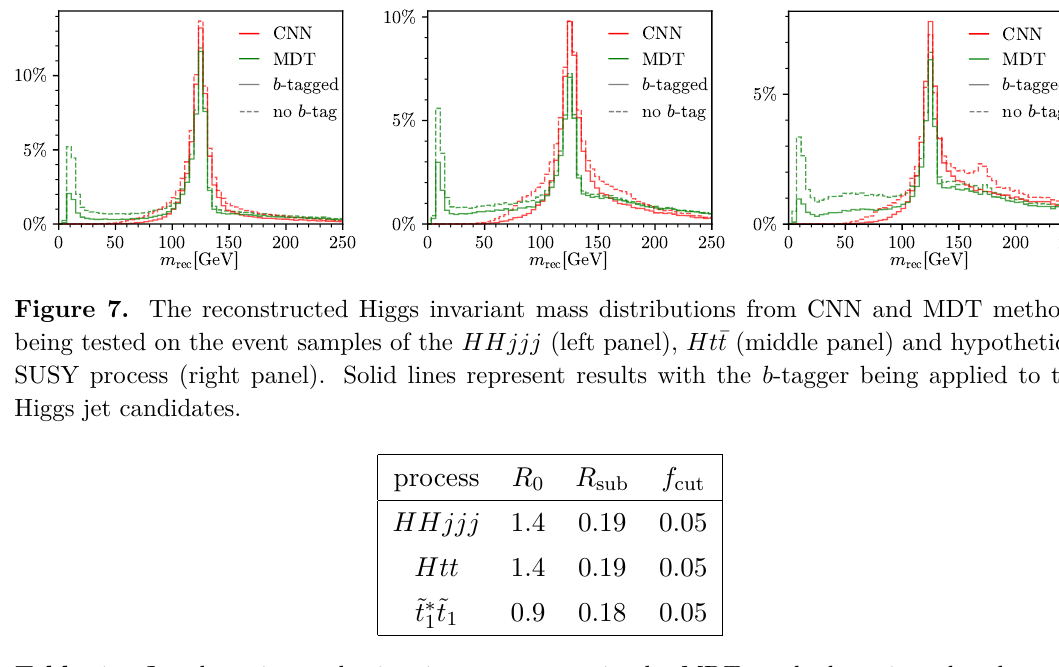
Table 1. Jet clustering and trimming parameters in the MDT method, as introduced at the beginning of section 4.